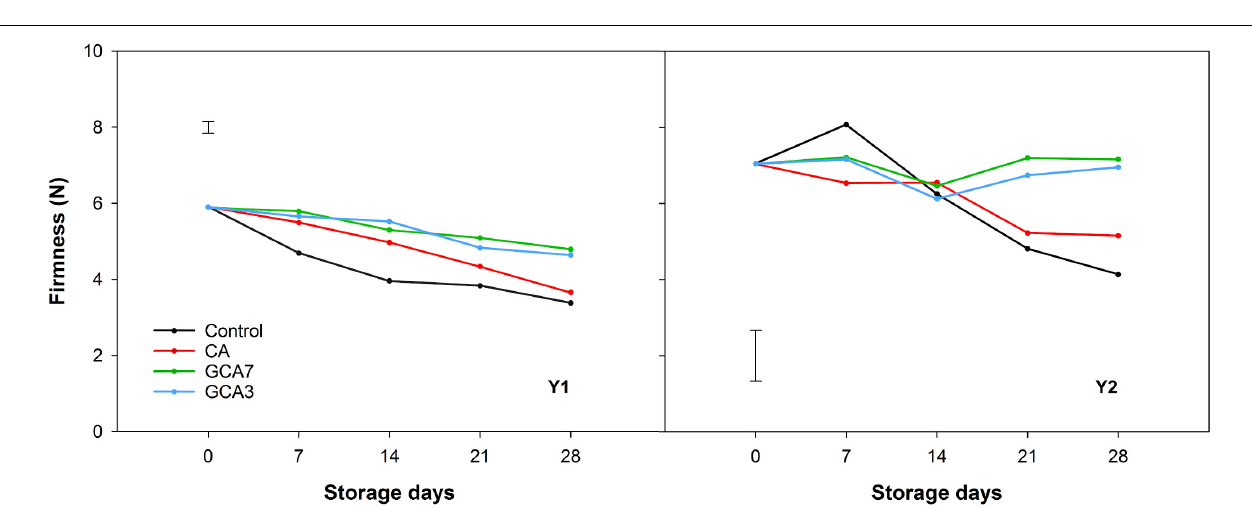
FIGURE 5 | Firmness expressed as Newton (N) of “Duke” blueberry fruit subjected to controlled atmosphere (CA) applications throughout 28 days of storage at 0 ◦ C and 90–95 RH%; air [control]; standard CA (10 kPa CO 2 + 5 kPa O 2 ); graduated CA 7 (GCA7; 7 days to achieve standard CA values); and GCA3 (3 days to achieve standard CA values). Two consecutive seasons are considered 2017 (year 1; Y1) and 2018 (Y2). Data represents means ( n = 30). Least Significant Differences (LSD) are included as: LSD treatment = LSD time = 0.310 for Y1 and LSD treatment ∗ time = 1.335 for